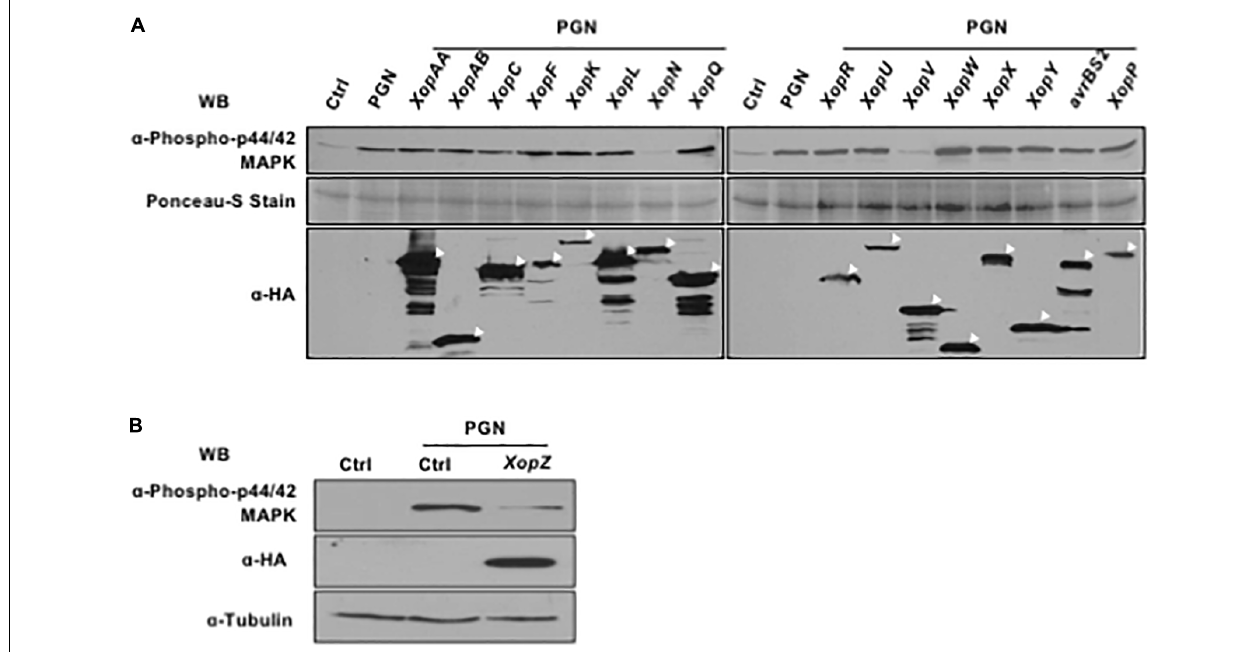
FIGURE 3 | Non-TAL effectors of Xoo suppress endogenous MAPK cascades induced by PGN. (A,B) Rice protoplasts were transfected with constructs individually expressing Non-TAL effectors overnight and then treated with 5 mg/ml PGN for 15 min. MAPK activation (top), non-TAL effector expression (bottom, indicated with white arrow heads) and loading control (bottom) are shown. All experiments were repeated three times with the similar results.